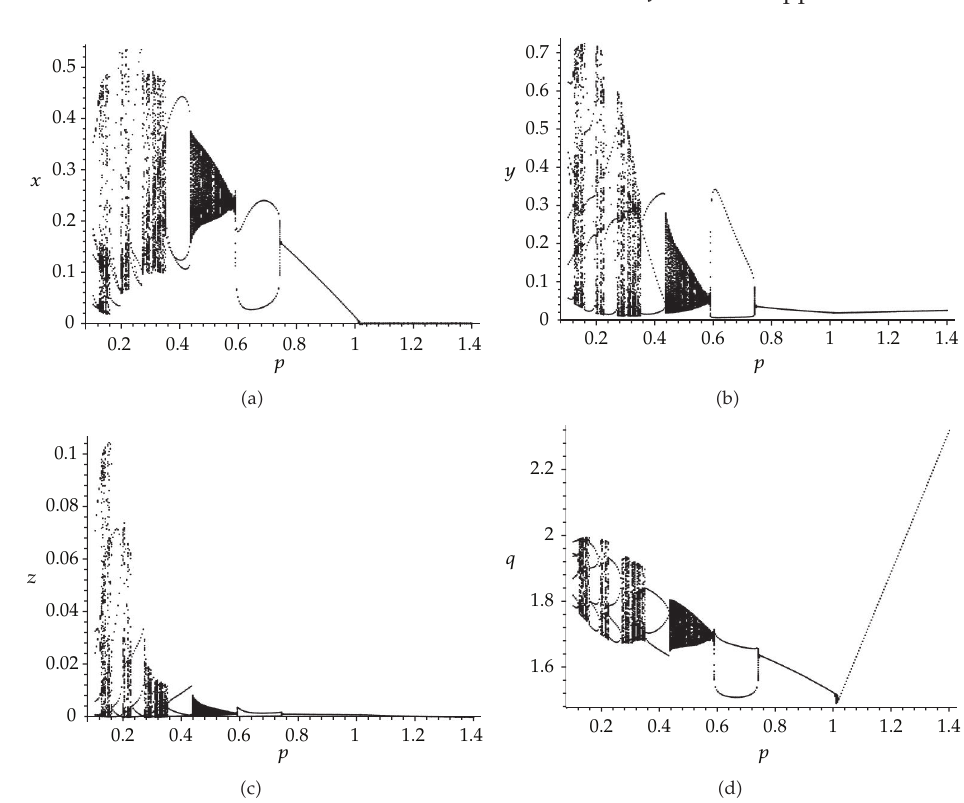
Figure 4: Bifurcation diagram of system (cid:2) 1.3 (cid:3) with initial conditions x (cid:2) 0 (cid:3) (cid:7) 0 . 1, y (cid:2) 0 (cid:3) (cid:7) 0 . 2, z (cid:2) 0 (cid:3) (cid:7) 0 . 3, q (cid:2) 0 (cid:3) (cid:7) 0 . 4, 0 . 1 ≤ p ≤ 2 . 4, b (cid:7) 8, d (cid:7) 3, c (cid:7) 3, e (cid:7) 0 . 2, and f (cid:7) 3s, g (cid:7) 2 . 5, h (cid:7) 0 . 1, m (cid:7) 0 . 2, j (cid:7) 0 . 1, k (cid:7) 0 . 6, l (cid:7) 0 . 008, a (cid:7) 3, p (cid:7) 0 . 6.